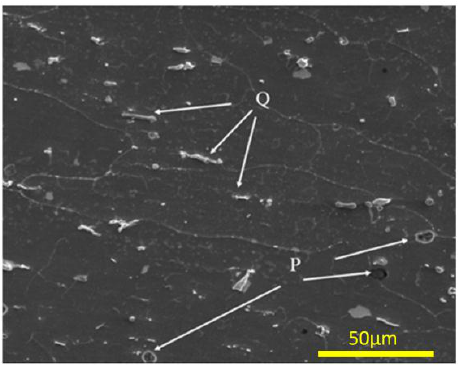
Figure 1. Scanning Electron Microscopy (SEM) image of base metal AA6061-T6.